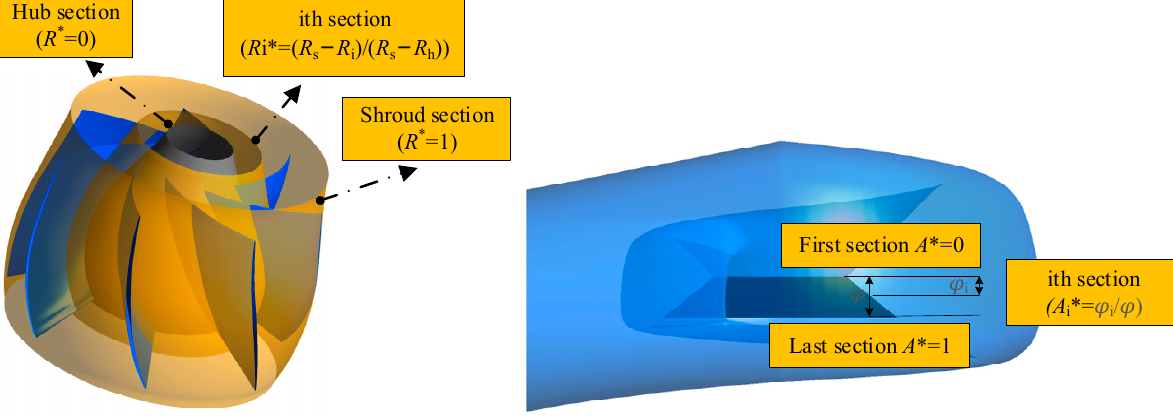
Figure 13. The axial sections of the impeller and pumping chamber.